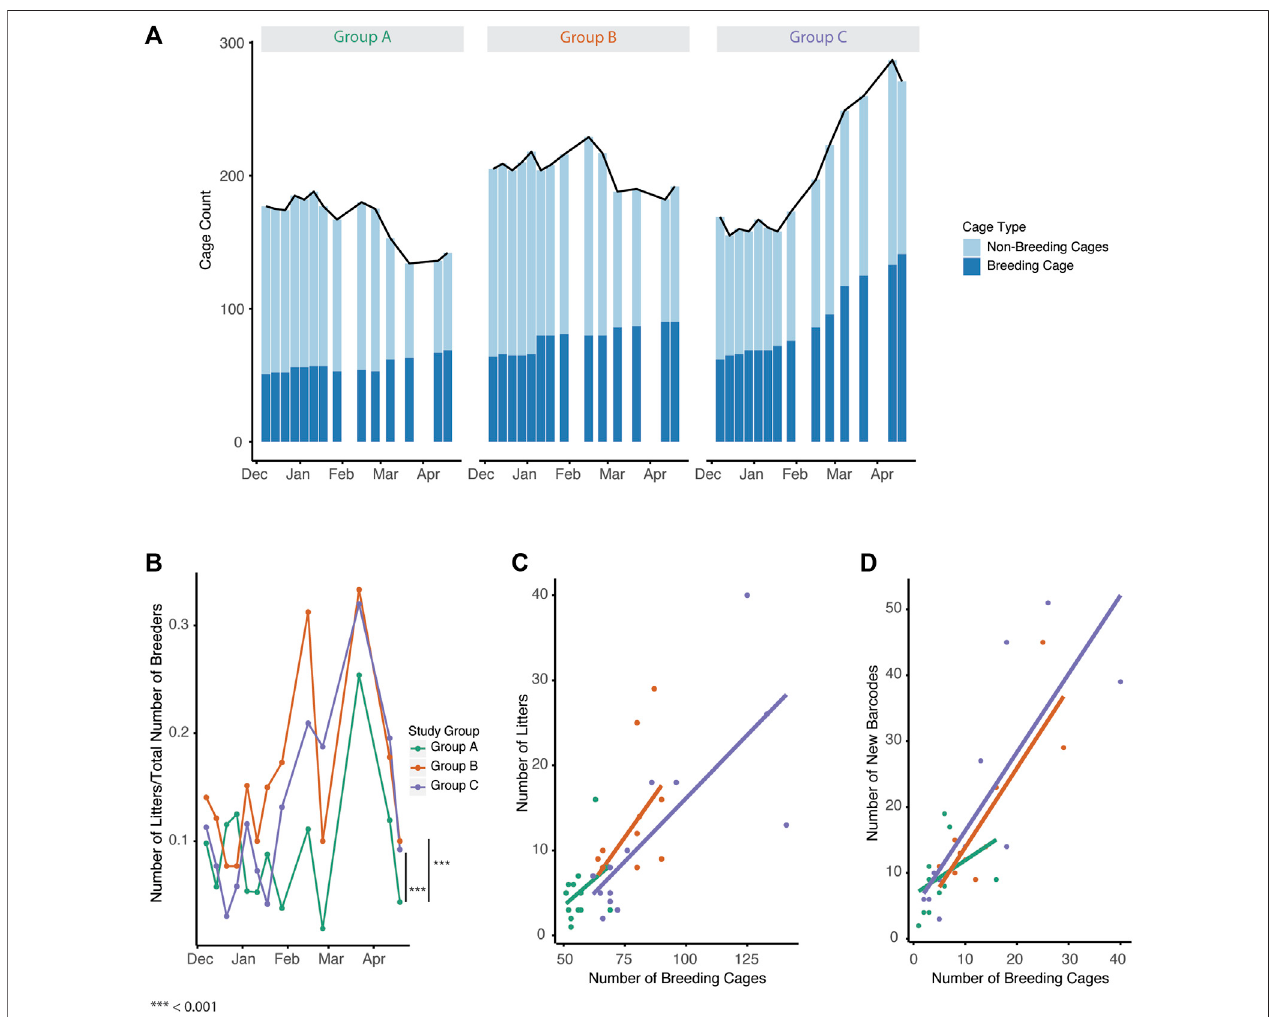
FIGURE 3 | Increased breeding management and automated genotyping increased breeding ef fi ciency. (A) Cage census for breeding (dark blue) and non- breeding (light blue) cages for Groups A-C. Line represents the total cage census. (B) Ratio of number of litters to total number of breeders for each group over time (Mixed effectlinearregression, p =0.00038,0.0037Group B,C) (C) Numberofbreedingcagescomparedtonumber oflitters forGroupsA-C (Spearmancorrelationr= 0.291, 0.622, 0.748 p = 0.335, 0.023, 0.0033) (D) Number of breeding cages compared to number of new barcodes for each group over time (Spearman correlation r = 0.051, 0.618, 0.786, p = 0.883, 0.0427, 0.0018)